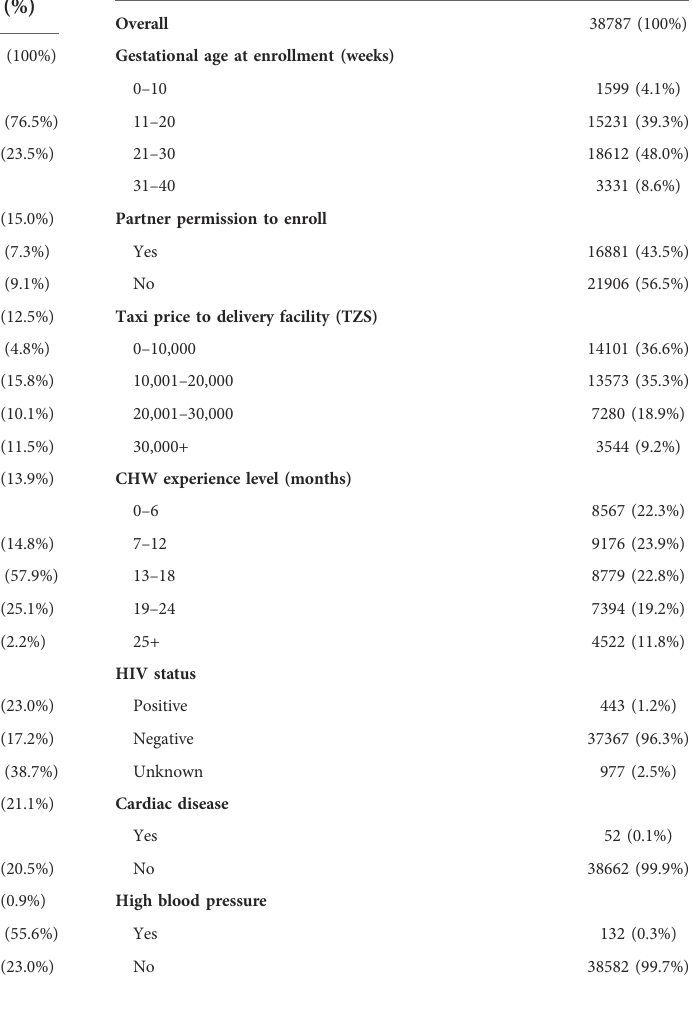
TABLE 1 Demographic characteristics ( n =38,787).